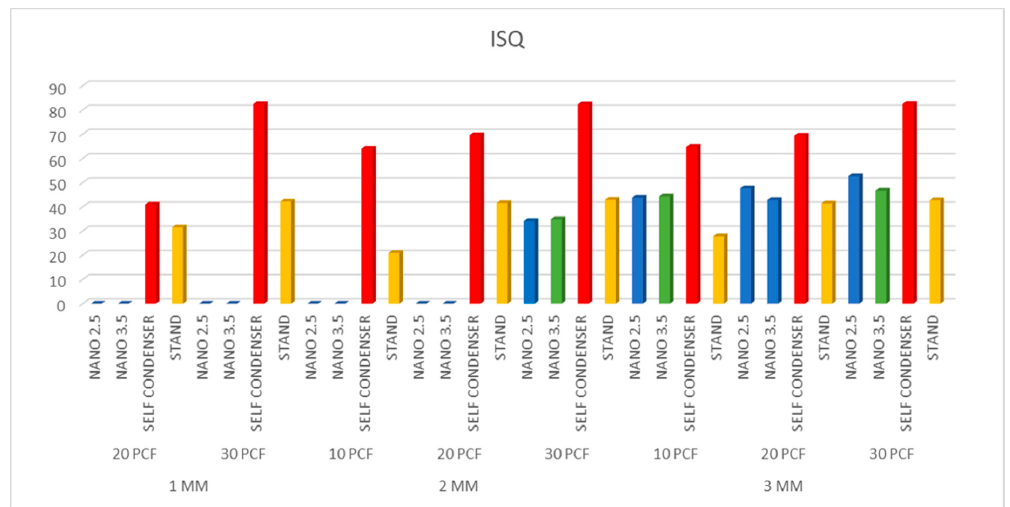
Figure 4. Results of the investigation of pull-out torque. The self-condenser implant showed the highest ratio of stability.